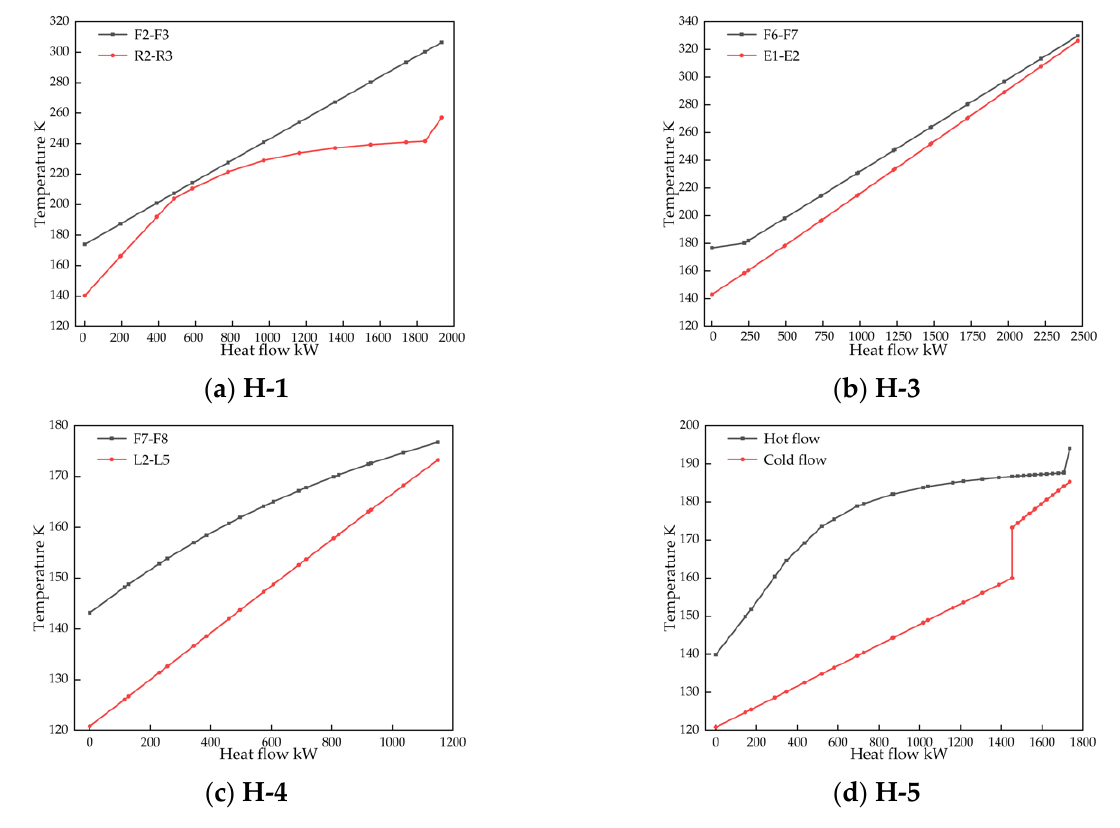
Figure 5. The temperature difference and heat flow in heat exchangers.